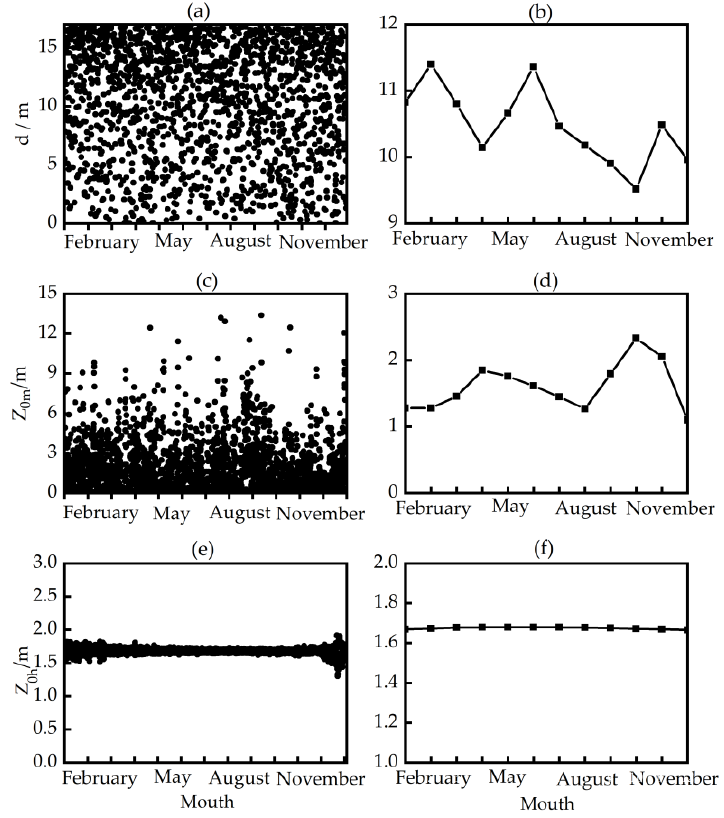
Figure 3. ( a ) Annual distribution scatter diagram of d ; ( b ) monthly average variation diagram of d ; ( c ) annual distribution scatter diagram of z 0 m ; ( d ) monthly variation diagram of average value of z 0 m ; ( e ) annual distribution scatter diagram of z 0 h ; ( f ) monthly variation diagram of average value of z 0 h .